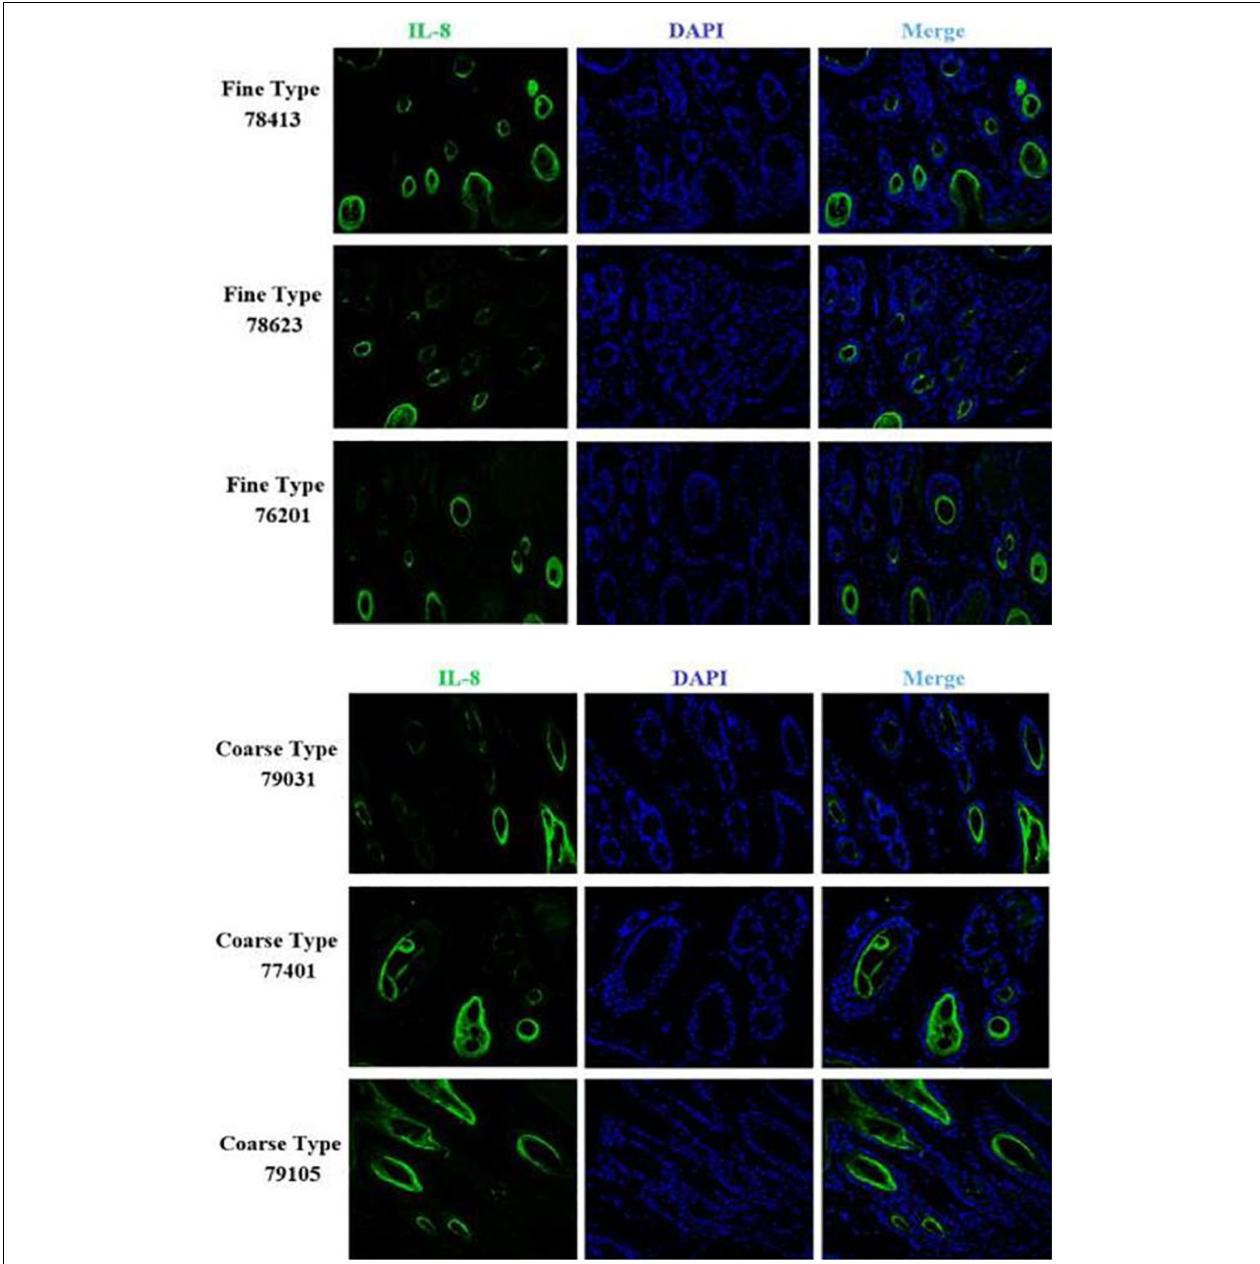
FIGURE 13 | IF results of CXCL8 in FT-LCG and CT-LCG skin tissues (200x).